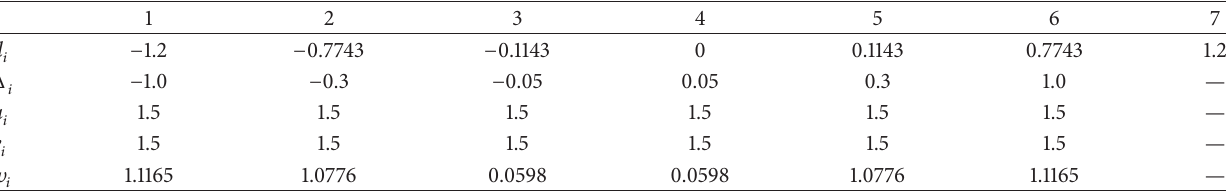
Table 2: Numerical results of Figure 1(d).